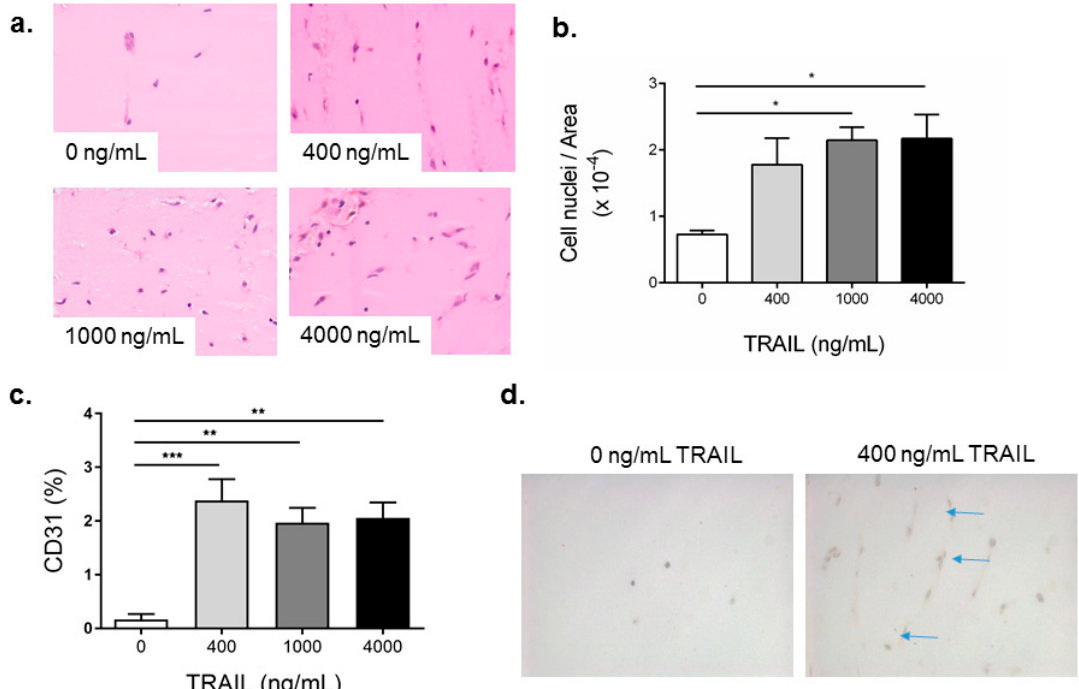
Figure 4. TRAIL promotes cell infiltration and increases EC content in Matrigel plugs. Liquid Matrigel containing increasing concentrations of TRAIL, as indicated, was injected subcutaneously into the flank of C57Bl/6J mice where it solidified and formed a plug. After 14 days, the plugs were excised, fixed, sectioned and assessed ( a ) by H&E for total cellular infiltration, with representative images and ( b ) quantification of total cell infiltration and ( c ) % CD31 staining in response to growth factors; ( d ) Representative images of CD31 staining (blue arrows) from 0 and 400 ng/mL TRAIL treated Matrigel plugs in mice. Images were taken at 40 × magnification. Results are expressed as the mean ± SEM ( n = 3 mice per condition); ANOVA; * p < 0.05, ** p < 0.01, *** p < 0.001.